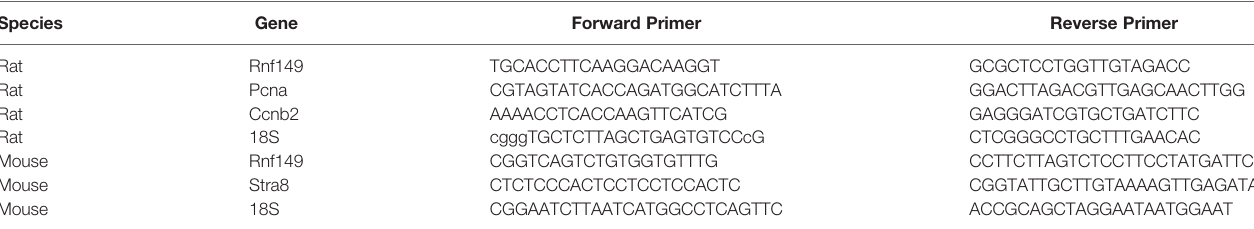
TABLE 1 | Quantitative real time PCR